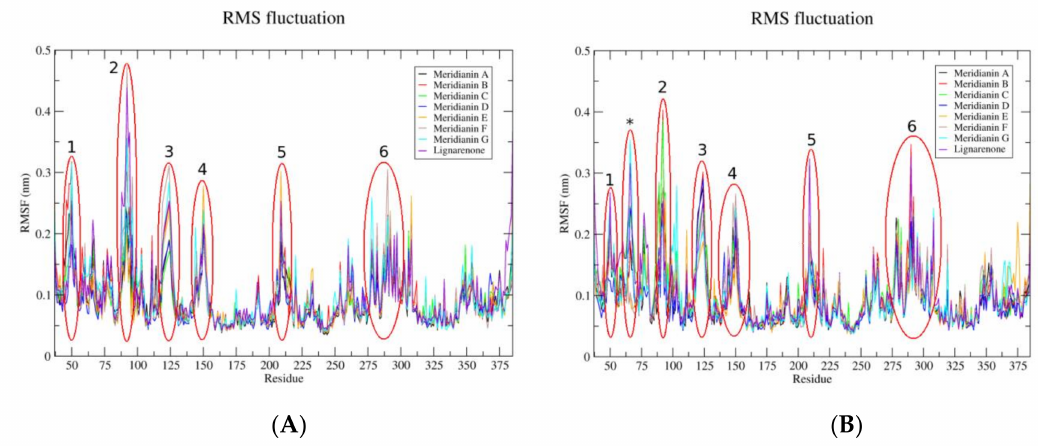
Figure 5. Root-mean-square fluctuation (RMSF) per residue (X-axis) values of each complex, GSK3 β + marine molecules separated per pocket, along the molecular dynamic (MD) simulation. The highest fluctuations ( > 0.25 nm) detected are highlighted with red circles and those shared between RMSFs are numbered in appearing order. The asterisk represents a fluctuation > 0.25 nm only observed on the substrate pocket. ( A ) On the left the RMSF of each system were marine molecules are bound to the ATP cavity and ( B ) on the right when the marine molecules are bound to the substrate pocket. The colour code for each system can be seen in the legend